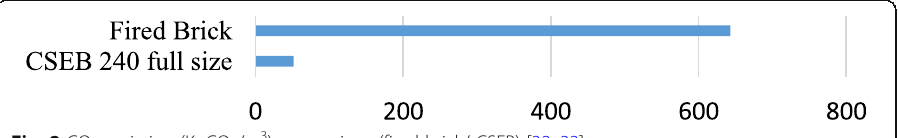
Fig. 2 CO 2 emission (KgCO 2 /m 3 ) comparison (fired brick/ CSEB) [32,